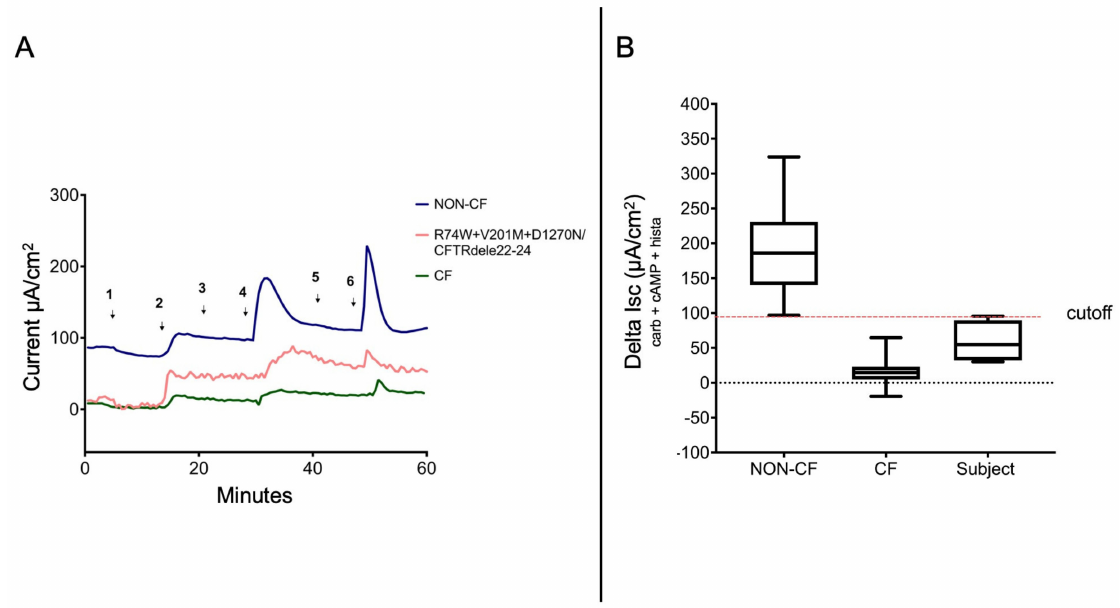
Figure 1. Recordings of short-circuit currents (Isc). ( A ) Representative ICM records for chlo- ride/bicarbonate transport. Experiments were performed in the presence of 10 µ M indomethacin. The arrows indicate the addition of the compounds in a standardized order to the mucosal (M) or serosal (S) side of the biopsies after 40 min of tissue equilibration: 100 µ M, M, amiloride (1. Amil), 10 µ M forskolin and 100 µ M IBMX, M + S (2. Fsk + IBMS), 10 µ M genistein M + S (3. geni), 100 µ M carbachol, S (4. Cch), 200 µ M DIDS, M (5. DIDS) and 500 µ M histamine, S (6. hista). Blue tracings: Typical ICM tracing for chloride/bicarbonate secretion of the non-CF subject; Pink tracings: ICM tracing for chloride/bicarbonate secretion of the subject in the study; Green tracings: ICM tracing for anions secretion of the CF subject; ( B ) Value for the sum Isc (FI + cch + H) for chloride secretion obtained from the control non-CF group, CF group and the